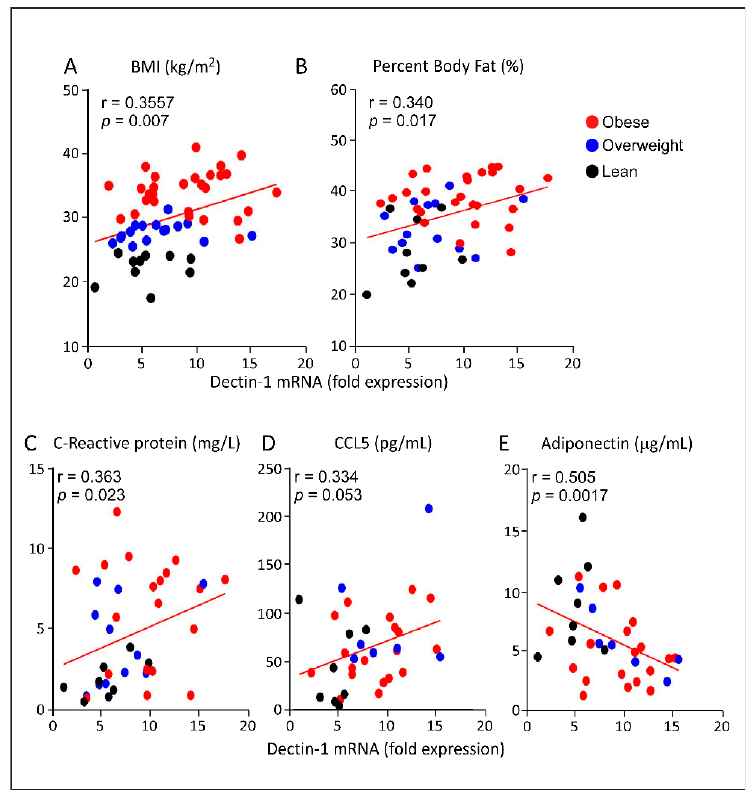
Figure 2. Correlation of the adipose tissue (AT) dectin-1 gene expression with metabolic and